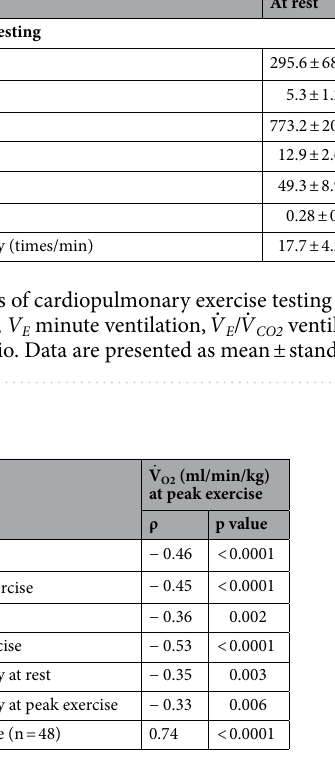
Table 3. Correlation coefficients between ˙ VO walk distance. 2 oxygen uptake, V T tidal volume, V E minute ventilation, carbon dioxide, V D /V T dead space to tidal volume